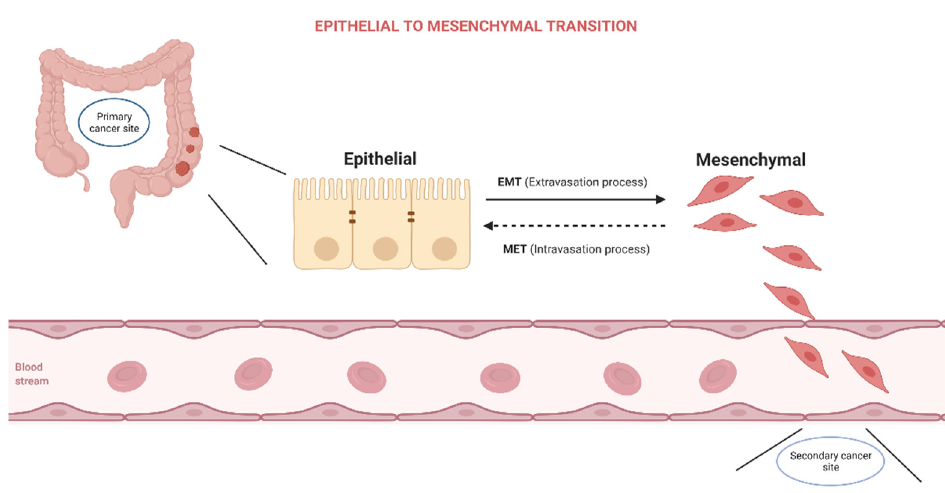
Figure 1. Epithelial to Mesenchymal Transition.